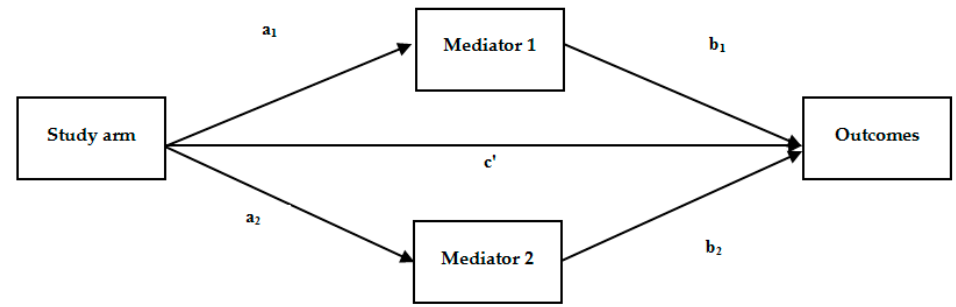
Figure 3. Multiple mediational model with two mediators (generic example). When the relationship between study arm and outcome is explained by the mediators (Mediator 1 and Mediator 2), it is called full mediational model. Furthermore, the model is consistent with partial mediation when the study arm still has a direct effect on outcome after including the mediators.